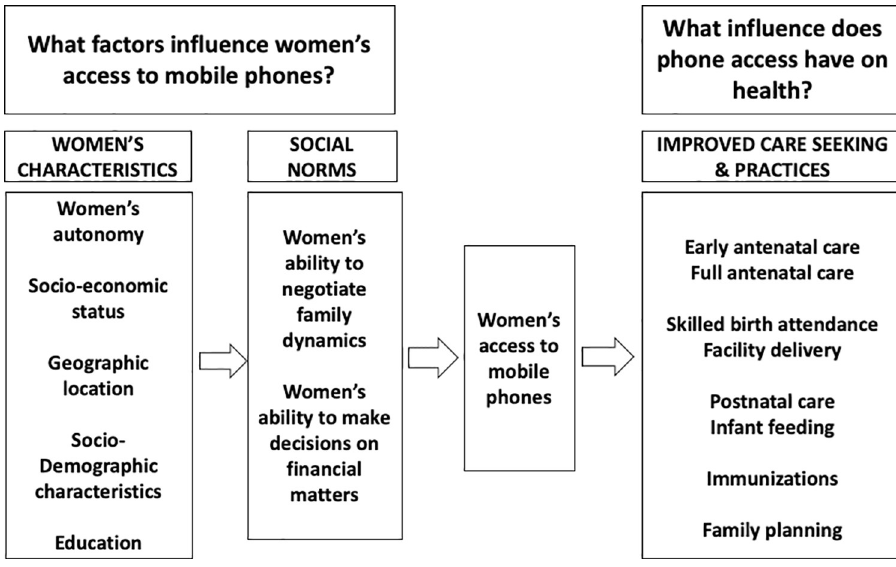
Fig 1. Conceptual framework for understanding factors underpinning women’s access to mobile phones and linkages between phone access and health behaviors.